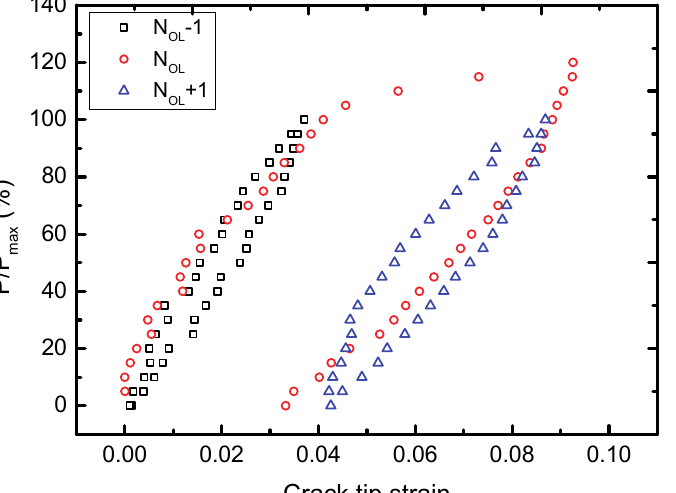
Figure 4: The strain evolution at the crack tip at OL-1, OL and OL+1 cycles (data points are extracted from the strain distribution with a distance of 50  m in front of the crack tip) Crack opening displacement